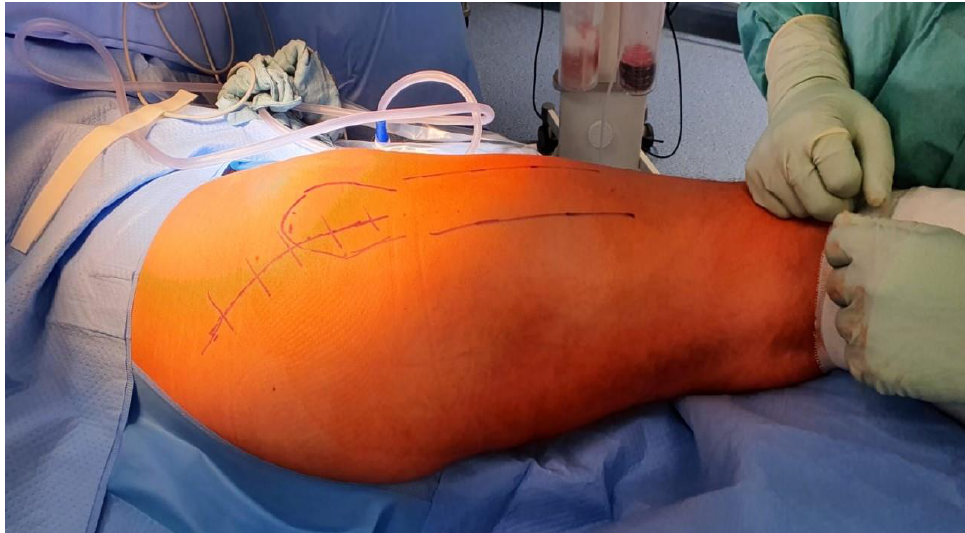
Figure 3. Anatomical landmarks for the surgical approach.